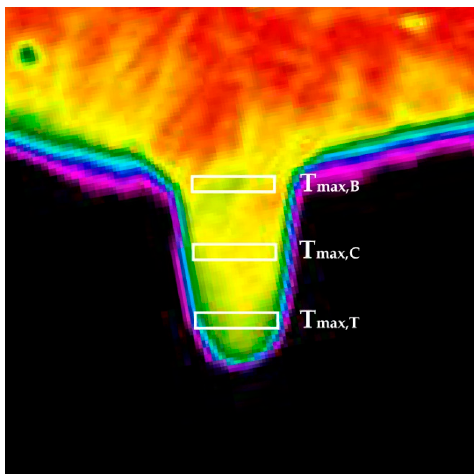
Figure 1. An example of an image acquired and elaboration performed in the study carried out.